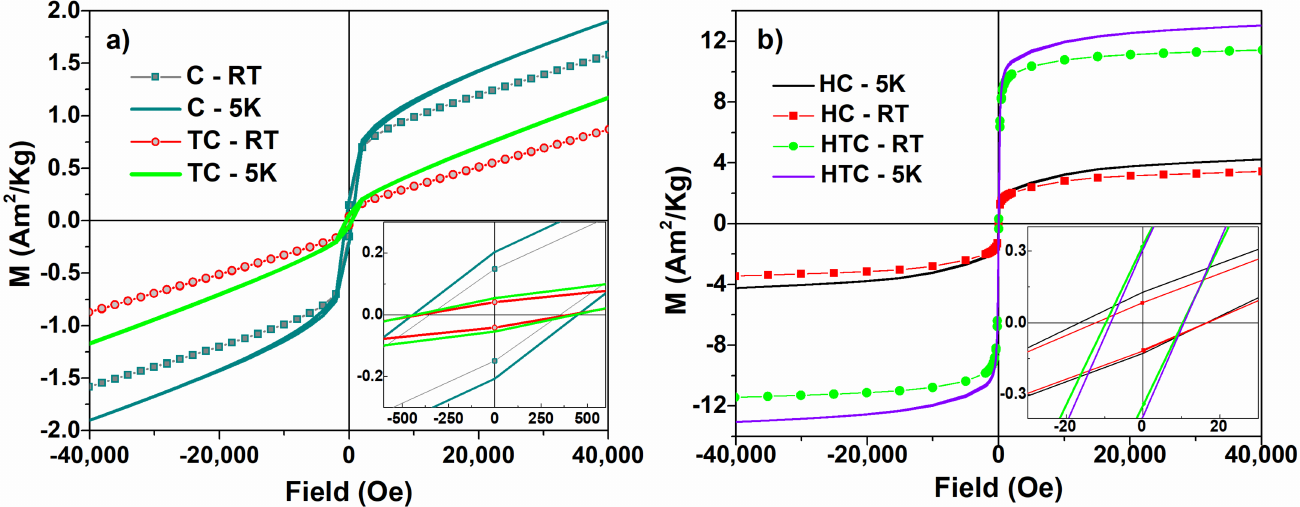
Figure 9. The hysteresis loops recorded at 5 K and 300 K for ( a ) C and TC samples; ( b ) the same for HC and HTC